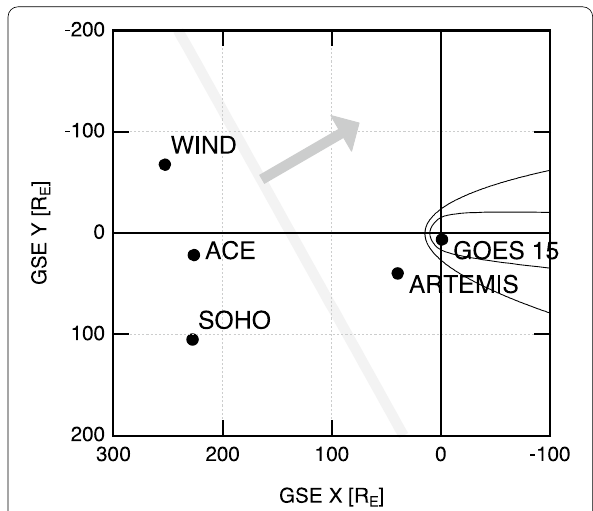
Fig. 3 Spacecraft positions and estimated orientation of the interplanetary structure (thick gray line). The thin curves show the typical locations of Earth’s bow shock and magnetopause (Fairfield